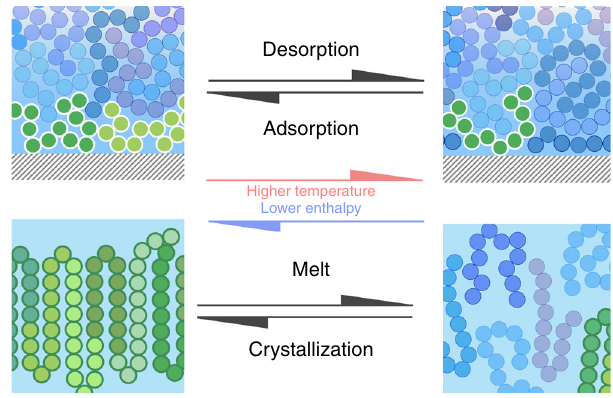
Fig. 5 Adsorption/desorption vs. crystallization/melting. In the schematics, adsorbed and crystallized chains are given in tones of green, whereas other chains are in tones of blue. Increasing the temperature of an interfacial polymer layer induces a phase transition related to a sudden reduction in the number of macromolecules adsorbed per unit surface. This process has a high af fi nity with the melting of a polymer